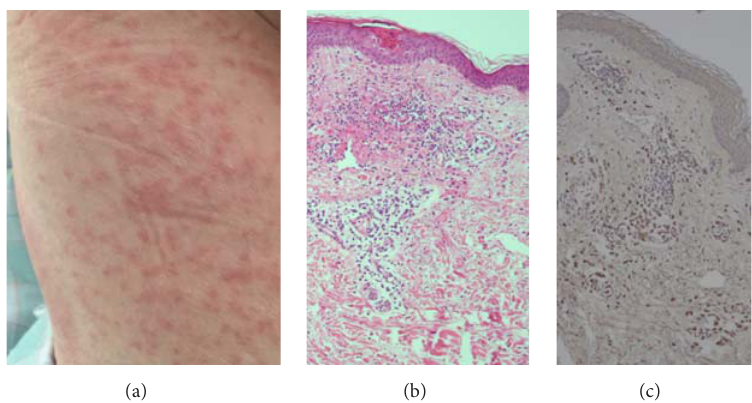
Figure 3: Findings of cutaneous lesions: photo of the rash on the right thigh (a). The biopsy shows the dense perivascular and periadnexal infiltration of mononuclear cells in the dermis extending into the subcutaneous tissue (b) (HE staining, original magnification × 100). The